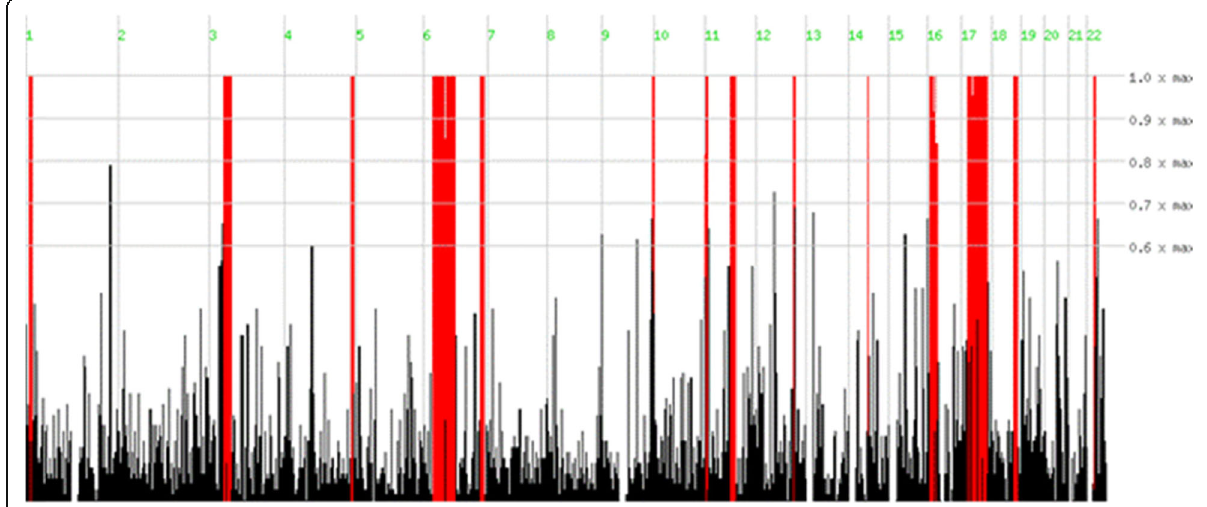
Fig. 3 Homozygosity region in the proband (V: 4) of pedigreeI. Coordinate homozygosity region on chromosome 17